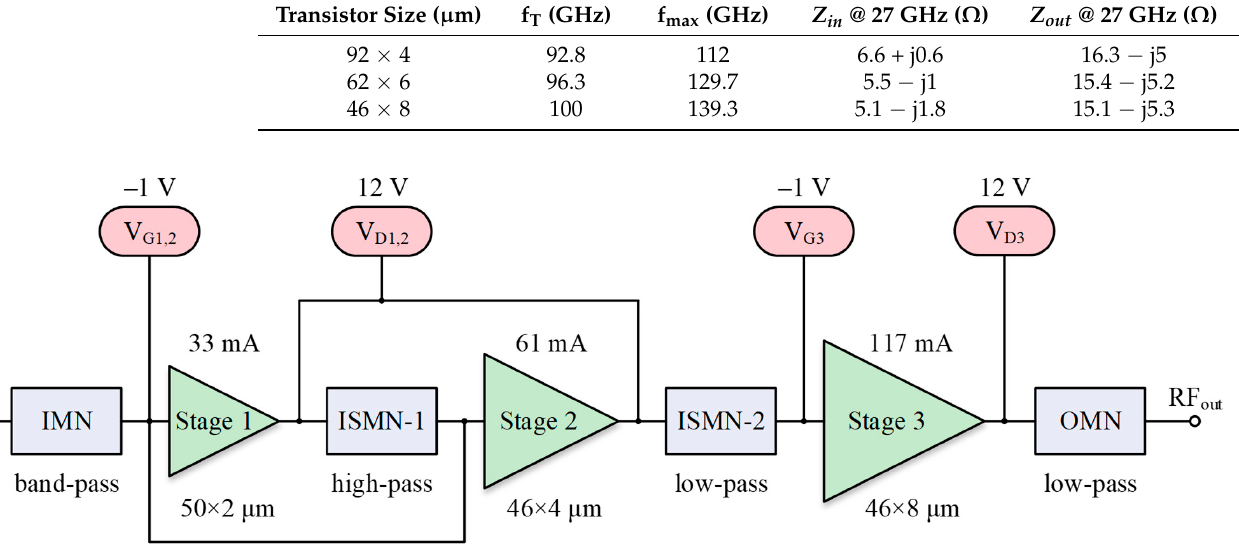
Figure 1. Block diagram of the proposed multistage power amplifier.